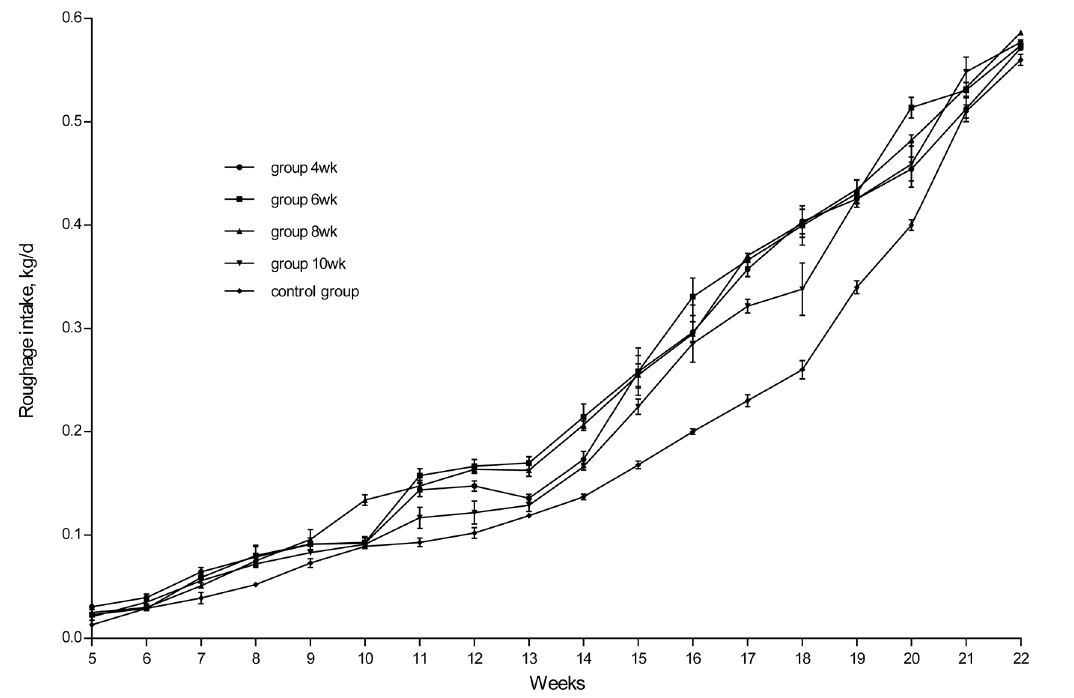
Figure 2. Effect of weaning age on roughage intake of calves from 5 wk to 22 wk shown as means±standard errors.